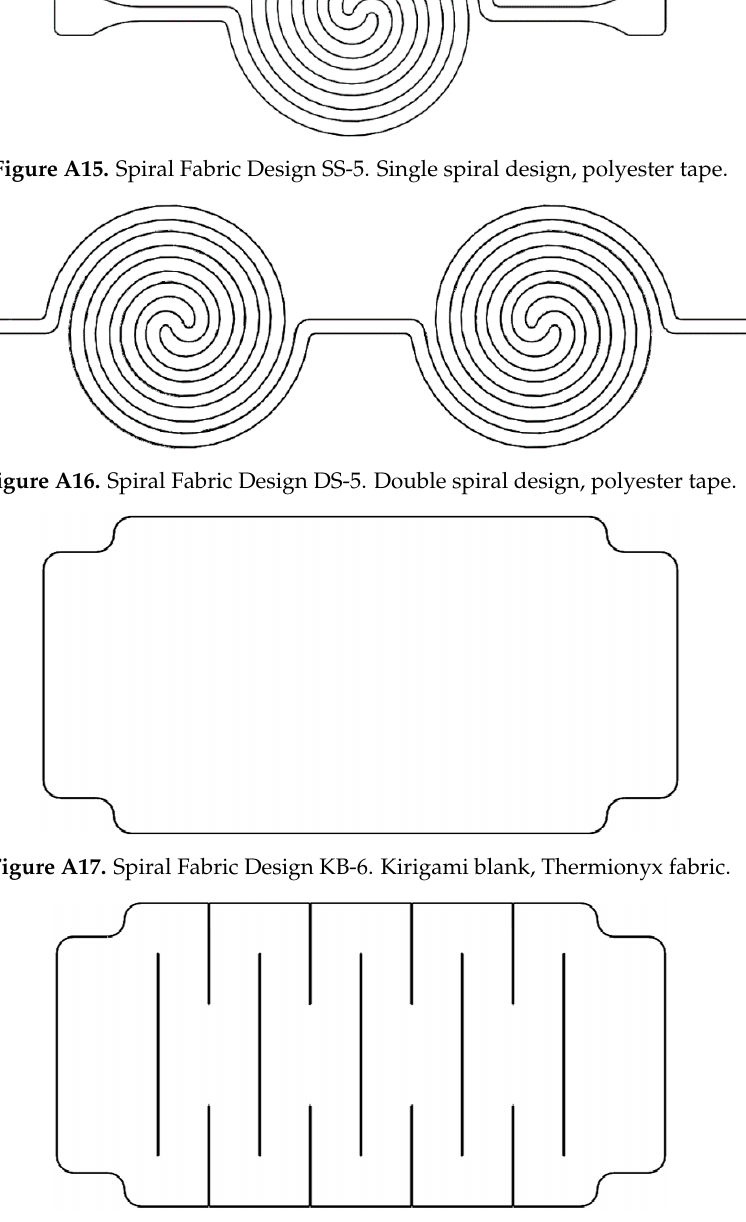
Figure A18. Spiral Fabric Design KL-6. Kirigami long cuts, Thermionyx fabric.